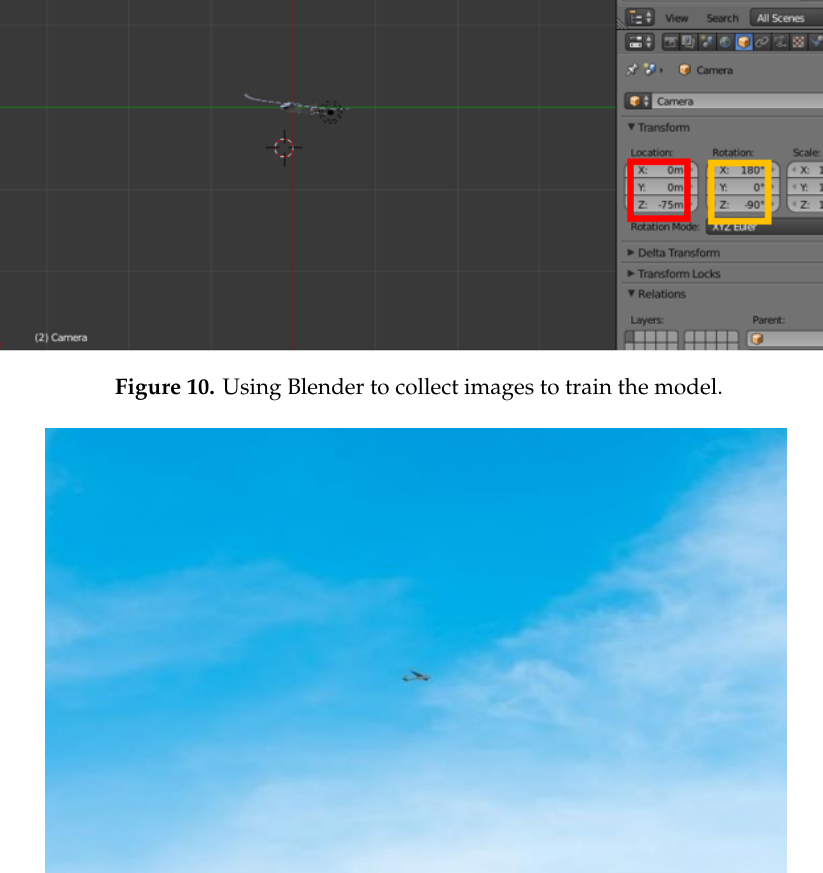
Figure 11. Synthetic image rendered by Blender.